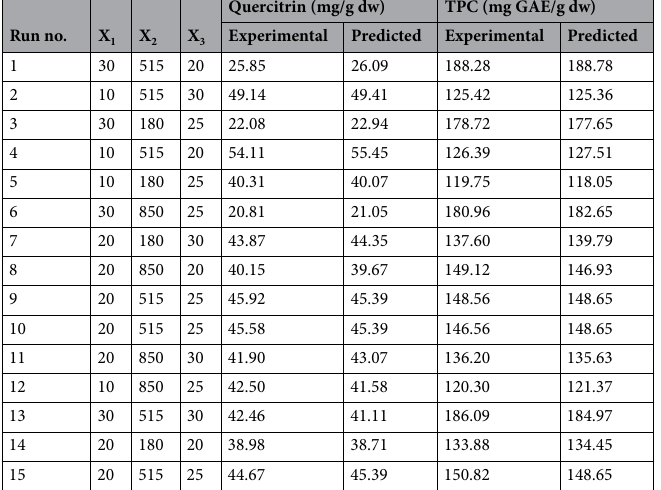
Table 2. BBD model fitness for optimum yield of quercitrin and TPC from C. caudatus leaves. X 1 = solvent to solid ratio, X 2 = particle size, and X 3 = time.